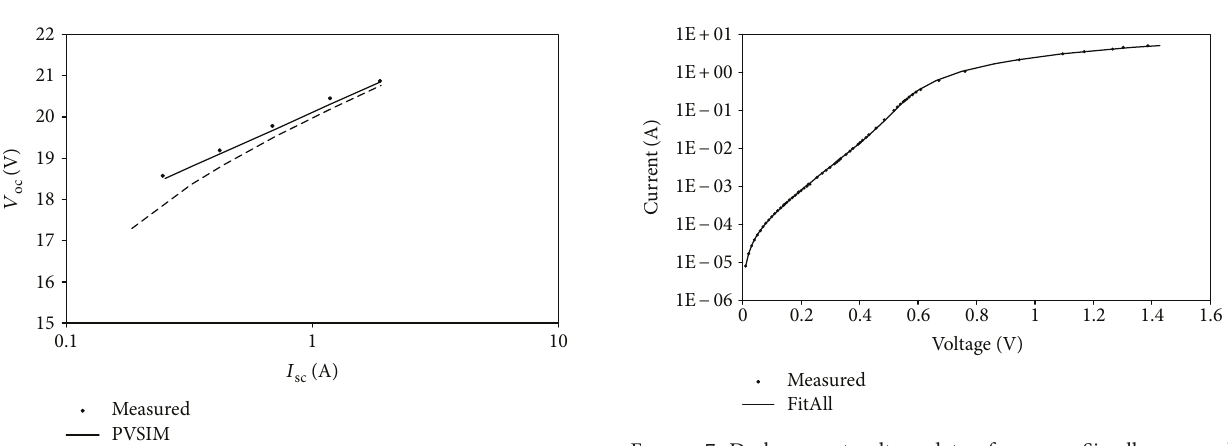
Figure 7: Dark current-voltage data of a mono-Si cell measured (symbols) and estimated (line) using FitAll. Table 1: I and n obtained from a nonlinear fi t to measure dark I-V 0 oc data of a single mono-Si cell.